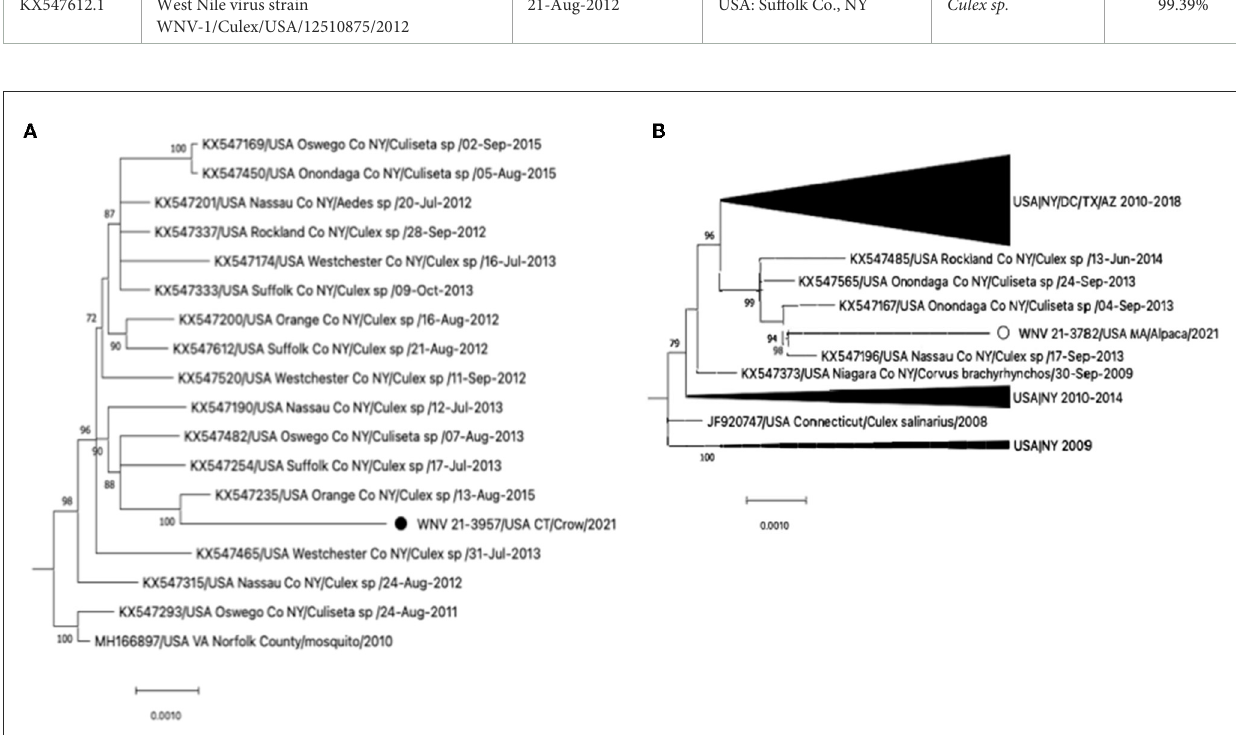
FIGURE1 (A) Expansion of the clade of WNV 21-3957/USA CT/Crow/2021 and (B) the clade of WNV 21-3957/USA CT/Crow/2021 from the full Maximum-likelihood tree in Supplementary Figure 2. The black circle and open circle identify WNV 21-3957/USA CT/Crow/2021 and WNV 21-3957/USA CT/Crow/2021 virus, respectively. The scale bars show the number of substitutions per site.